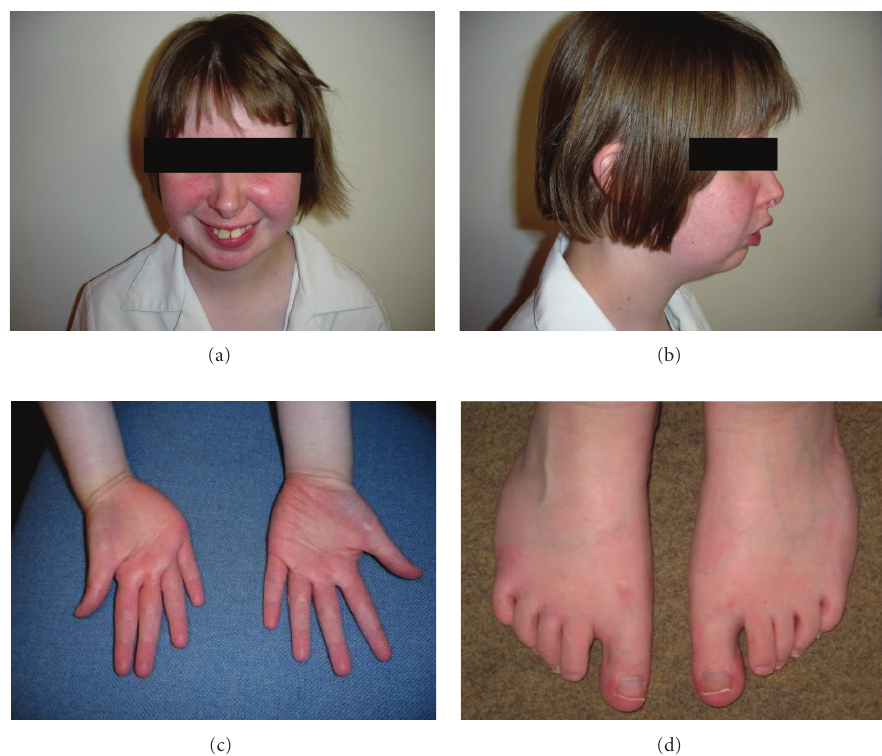
Figure 1: Clinical features of the patient at the age of 16.5 years. Frontal view (a) shows the short philtrum. Lateral view (b) shows mild micrognathia. (c) shows distal tapering of the fingers with radial clinodactyly of the middle three fingers, and (d) shows Long halluces, curly toes, and bilateral hallux